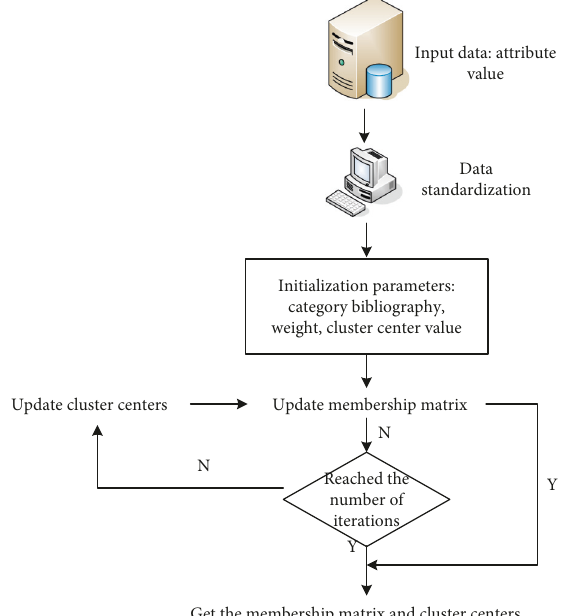
Figure 2: The process of fuzzing a single